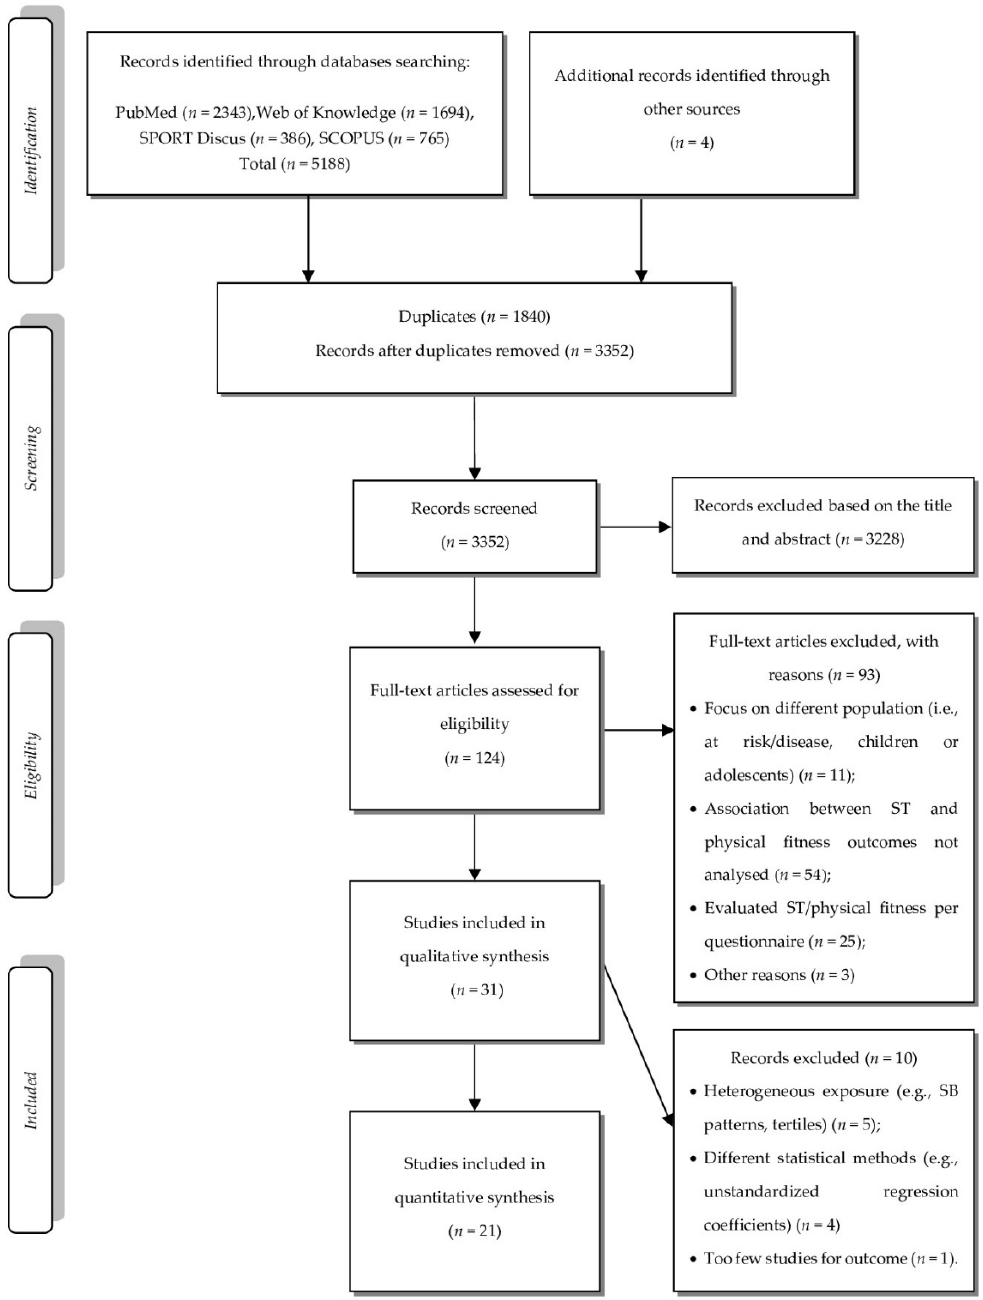
Figure 1. Flowchart illustrating each phase of the search and selecting process.